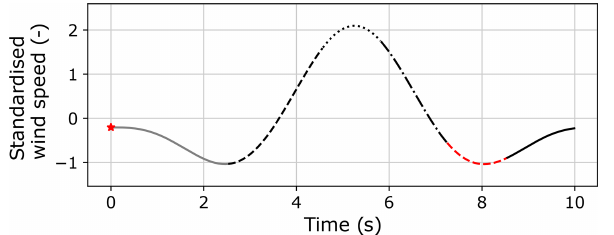
Figure 11. Standardised values of the wind speed (at 90m) dur- ing simulated gust events. Vertical-axis values give the number of standard deviations from the mean. Line segments in this figure cor- respond to those in Fig.